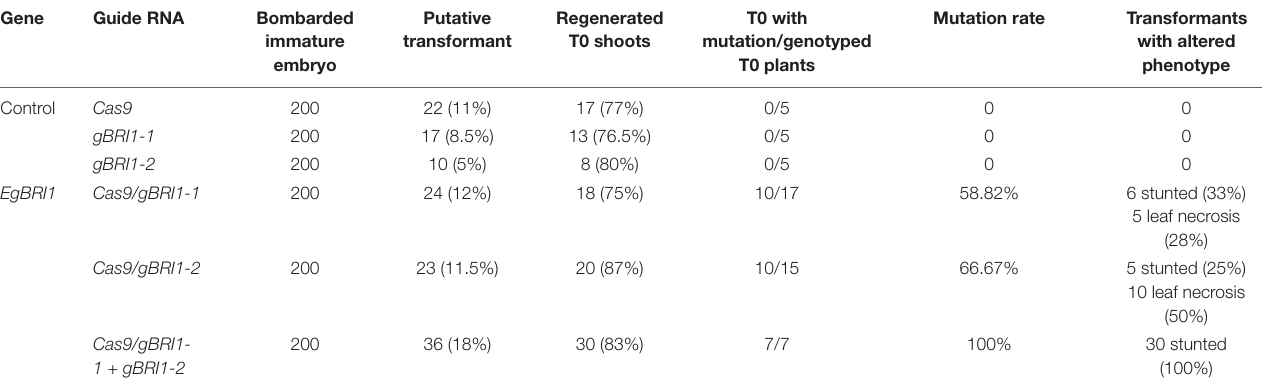
TABLE 2 | The efficiency of CRISPR/Cas9 and gRNA transformation targeting brassinosteroid-insensitive 1 (EgBRI1) gene in oil palm and the phenotypes of the transgenic plants. Gene Guide RNA Bombarded